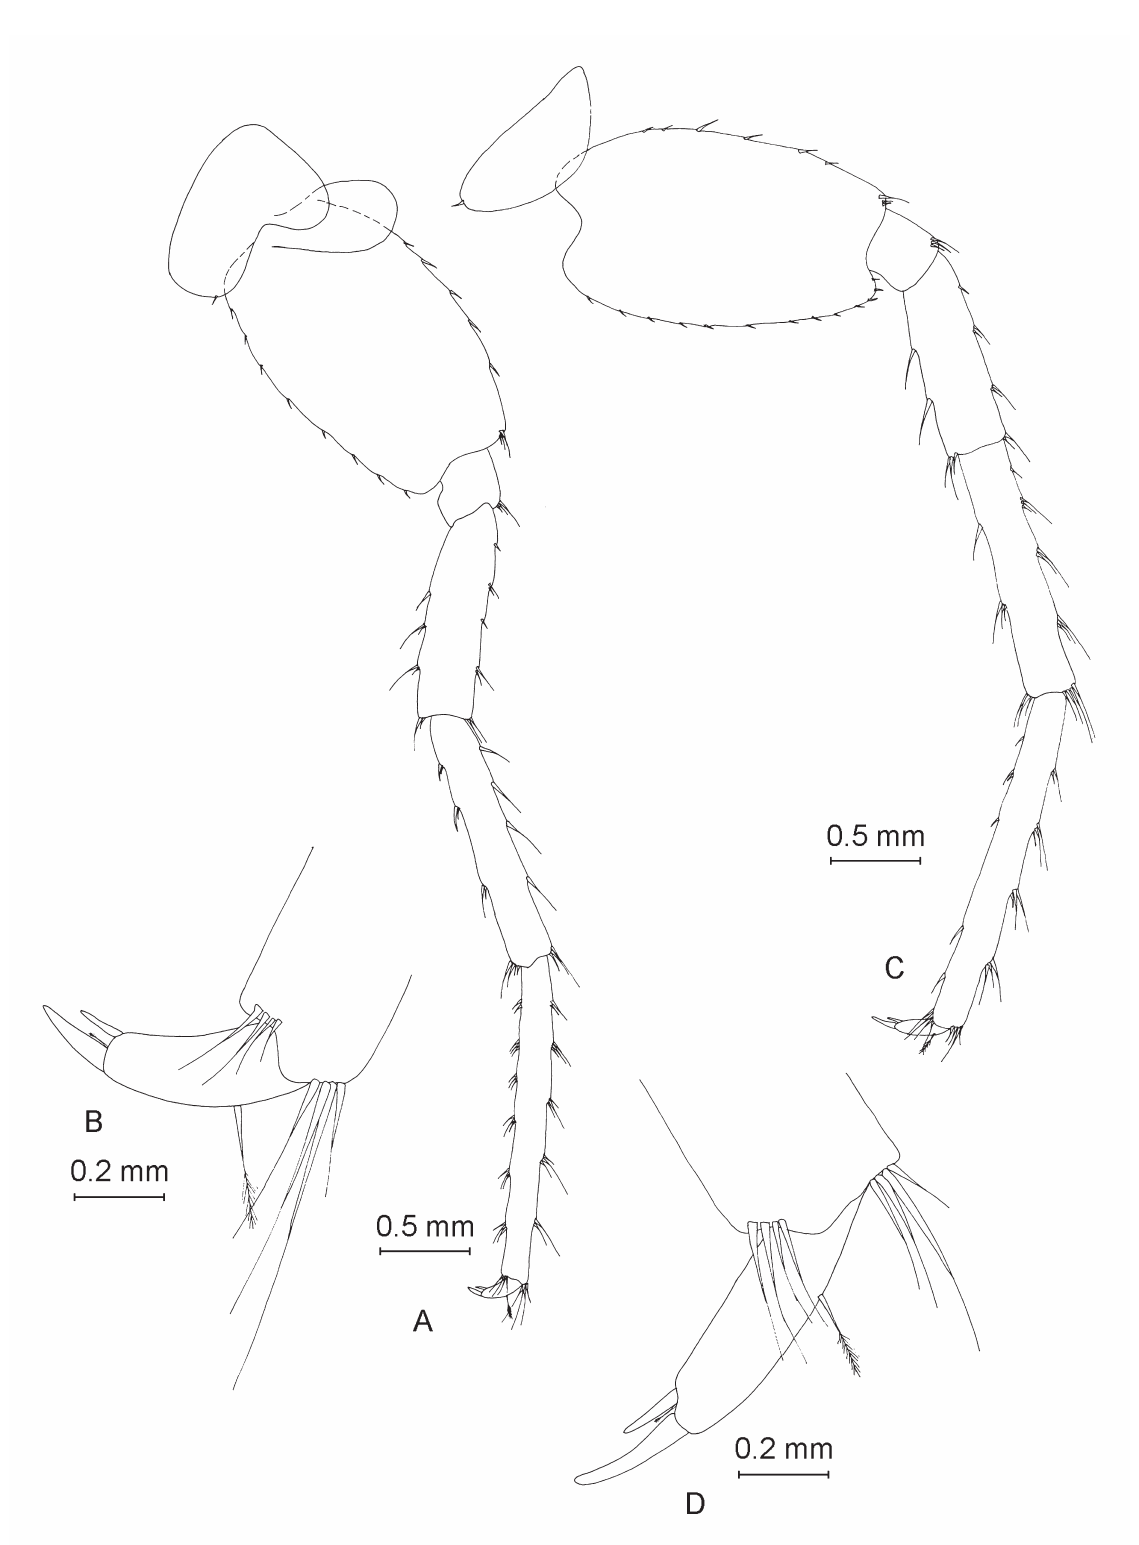
Fig. 13. ♀. A . Pereopod VI. B . Dactylus of pereopod VI. C . Pereopod VII. D . Dactylus of pereopod